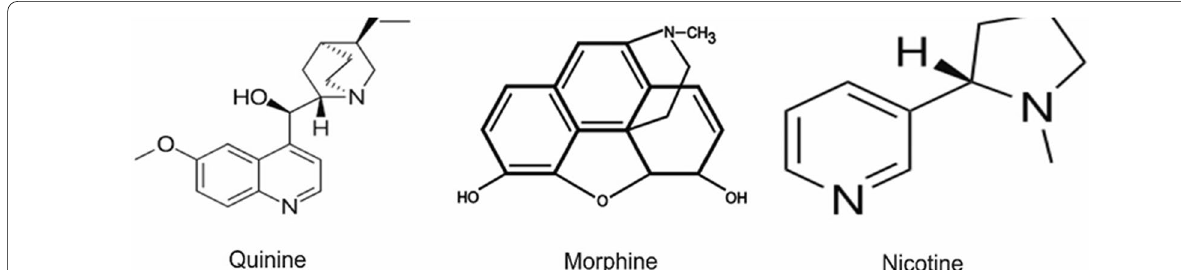
Fig. 6 Chemical structures of selected Alkaloids